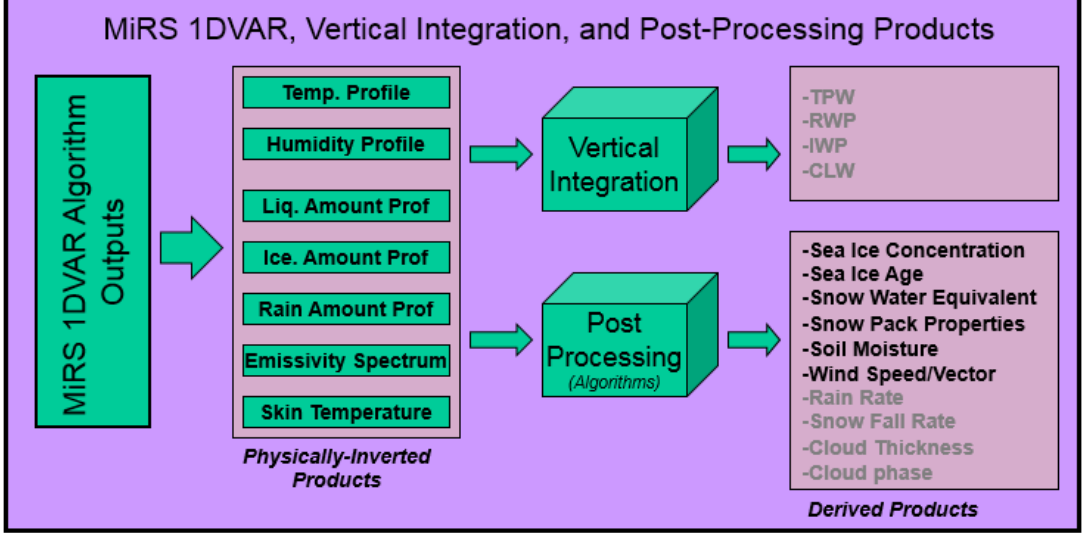
Figure 1. Products from the Microwave Integrated Retrieval System (MiRS) two-steps retrieval process. Products listed in bold under “Derived Products” are generated from the emissivity spectrum. Soil moisture and wind speed/vector are not current operational products. 1DVAR: one-dimensional, variational-based physical approach.